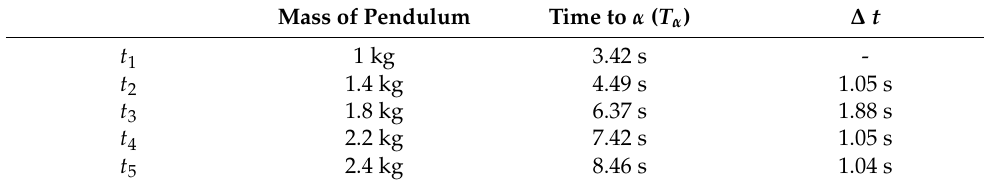
Figure 3. Absolute value of pendulum displacement with mass. Table 1. Power generation angles by mass.